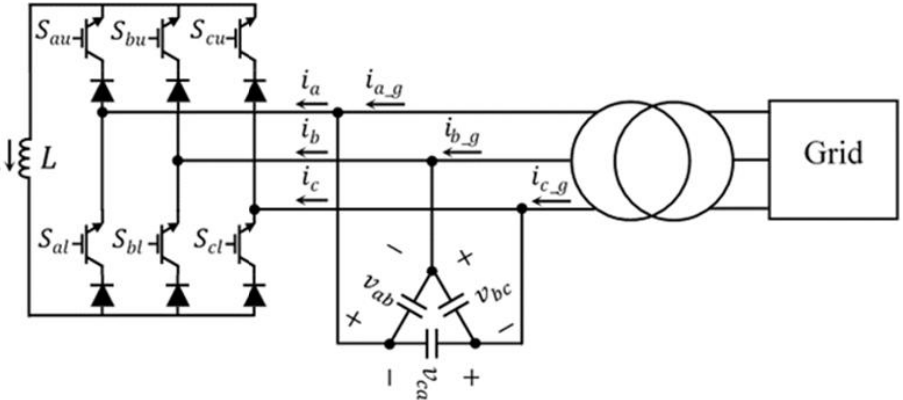
Figure 16. Grid Current-source based STATCOM for grid-connected utility for flexibility and ancil- lary